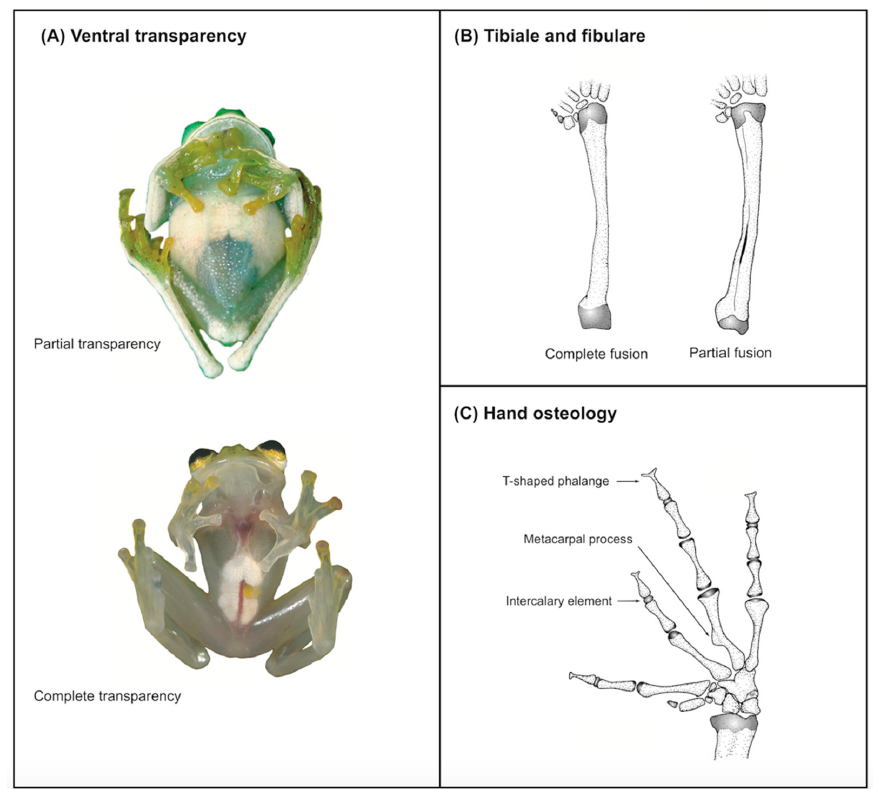
Figure 8. Synapomorphies of Centrolenidae. ( A ) Partial ( Nymphargus posadae , QCAZ 25090) and complete ventral transparency ( Hyalinobatrachium aureoguttatum , QCAZ 32070). ( B ) Partial ( N . wileyi , QCAZ 26029) and complete fusion between tibiale and fibulare ( H . munozorum , KU 155497). ( C ) Presence of medial process on Metacarpal III and intercalary element ( Teratohyla spinosa , KU 32935). The presence of T or Y-shaped terminal phalanges is a synapomorphy of Allocentroleniae (Allophrynidae + Centrolenidae). Photos in ( A ) by M. Bustamante. Modified from Guayasamin et al. [1].